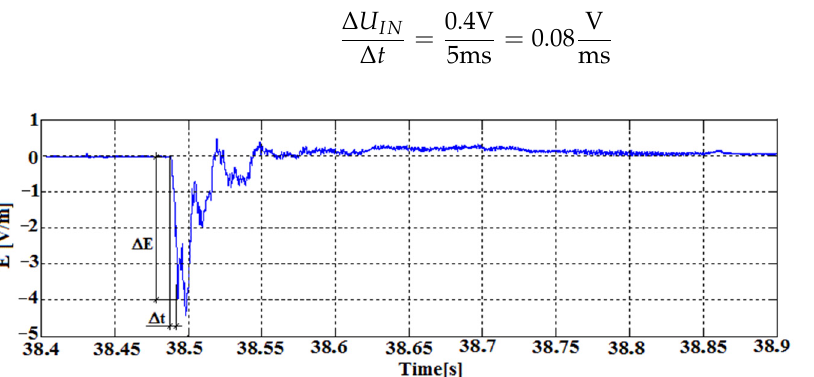
Figure 9. Example of electromagnetic emission signal recorded on the laboratory bench by the autonomous receiver.